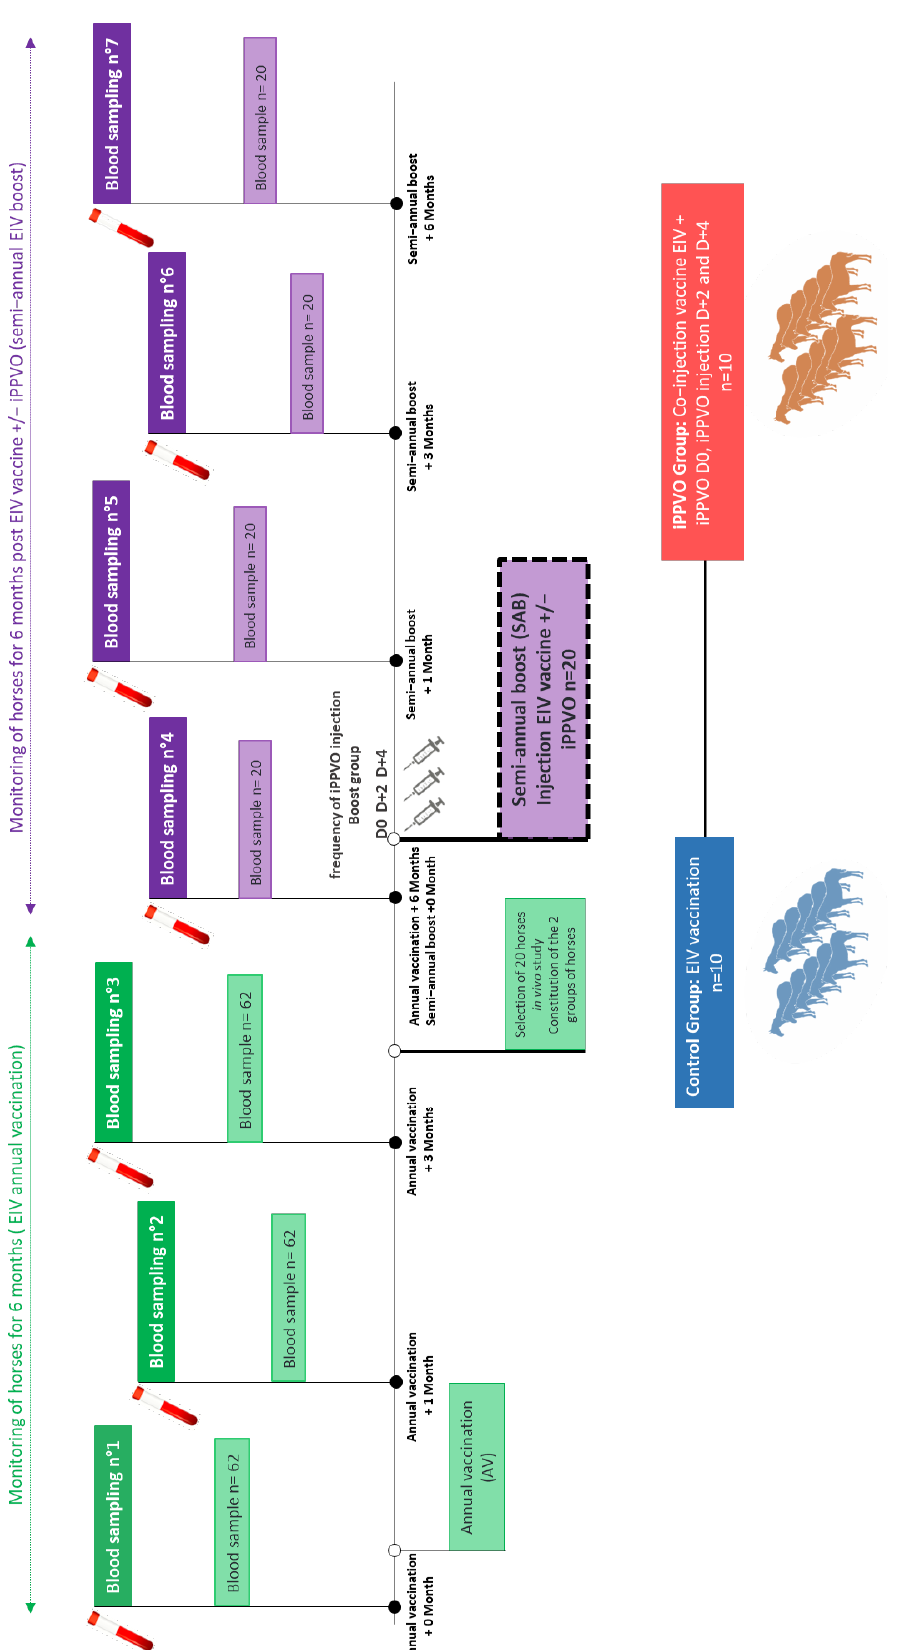
Figure 1. Horse selection and EIV vaccination protocol with or without iPPVO ® .